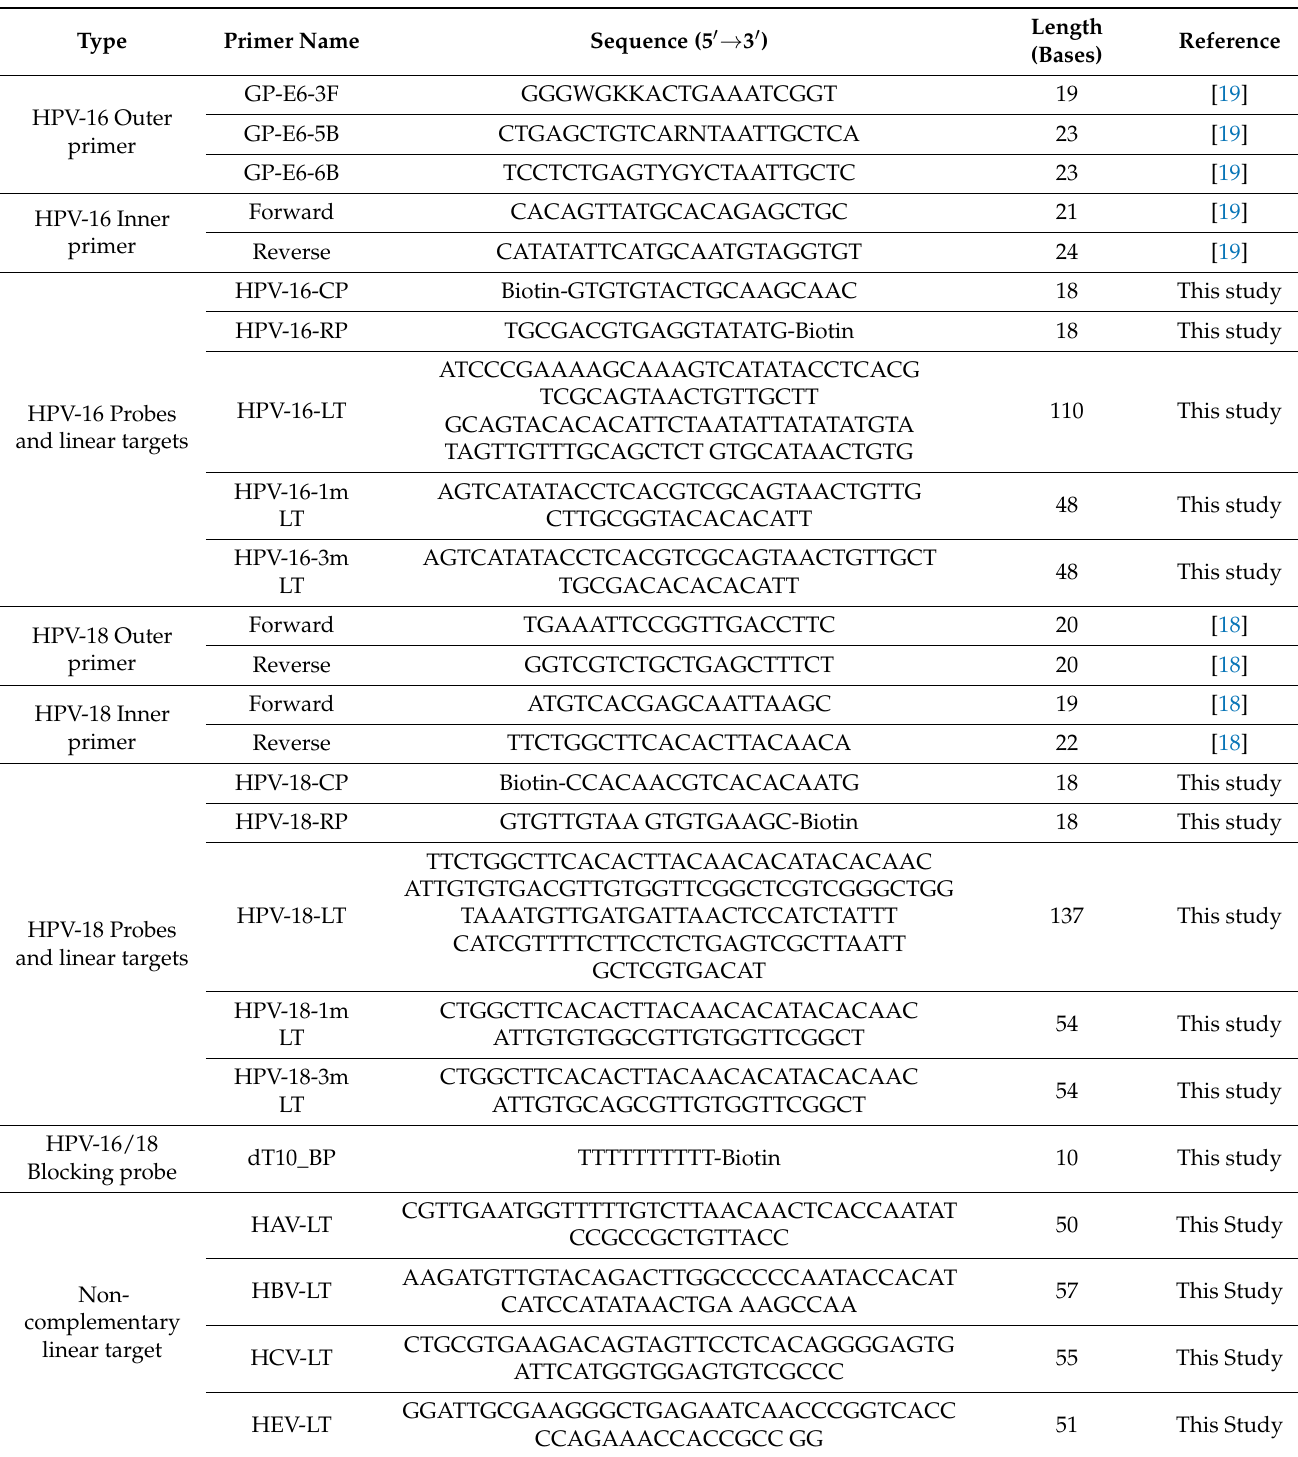
Table 1. The nested PCR primers, probes, and DNA linear targets used in this